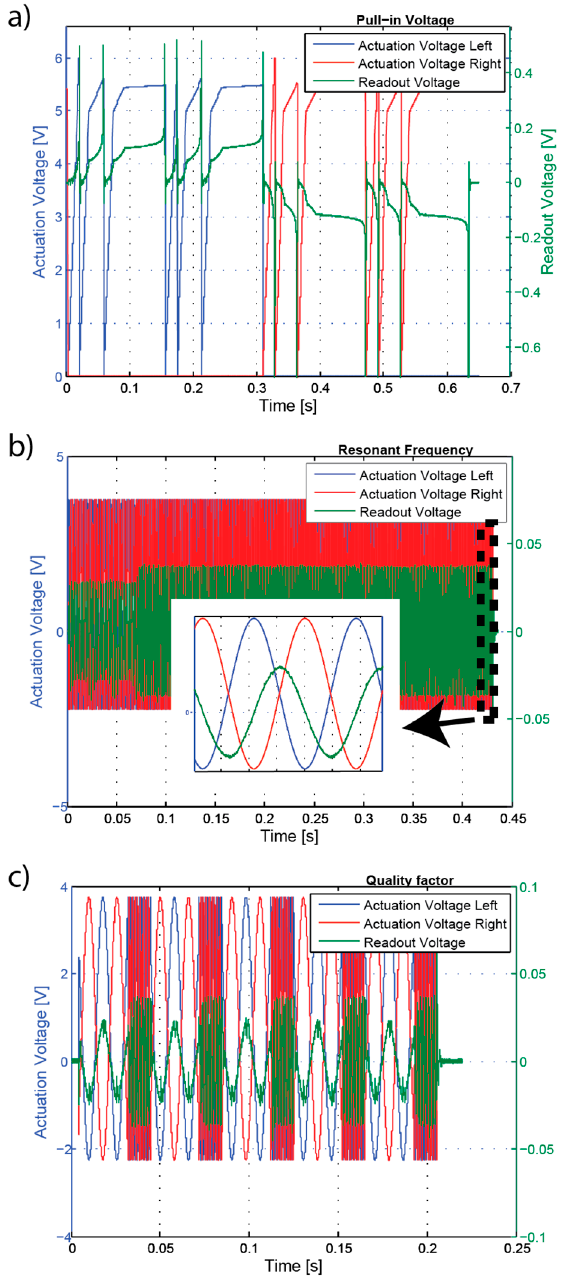
Figure 11. Full measurement cycle overview (actuation and voltage readout) ( a ) Pull-in voltages measurement cycle; ( b ) resonant frequency measurement cycle with inset showing 90° phase shift at resonance frequency; and ( c ) quality factor measurement cycle.